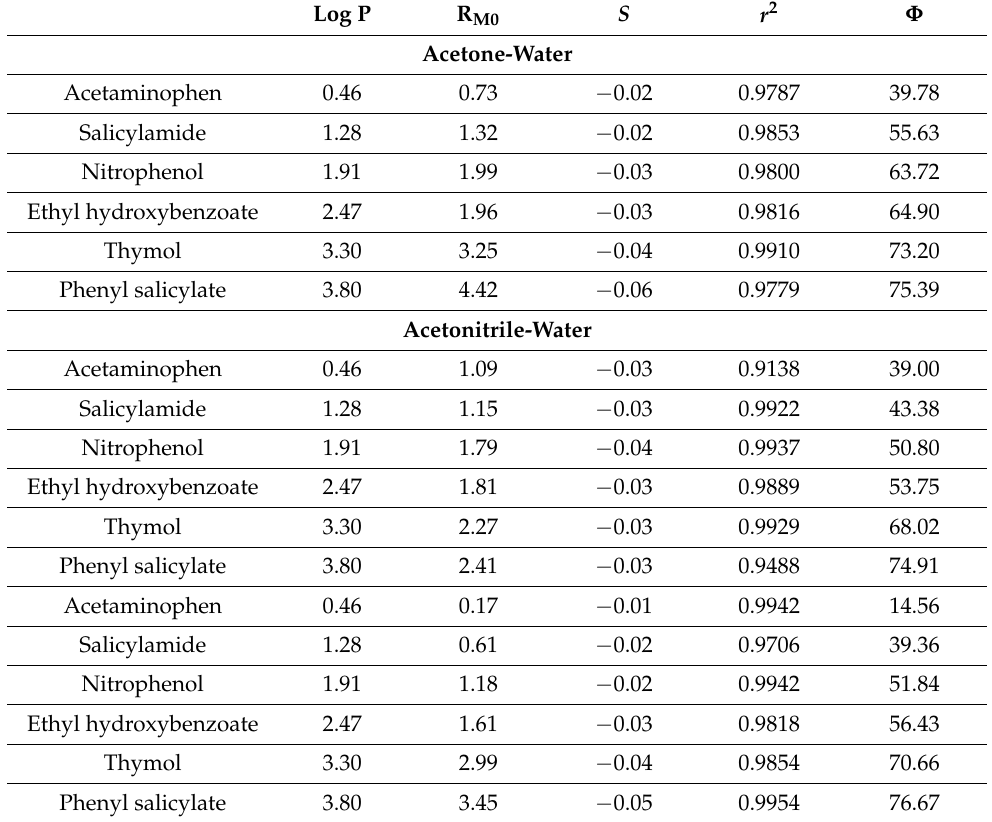
Table 5. The log P values from the literature [31] and the calculated R M0 values for the reference